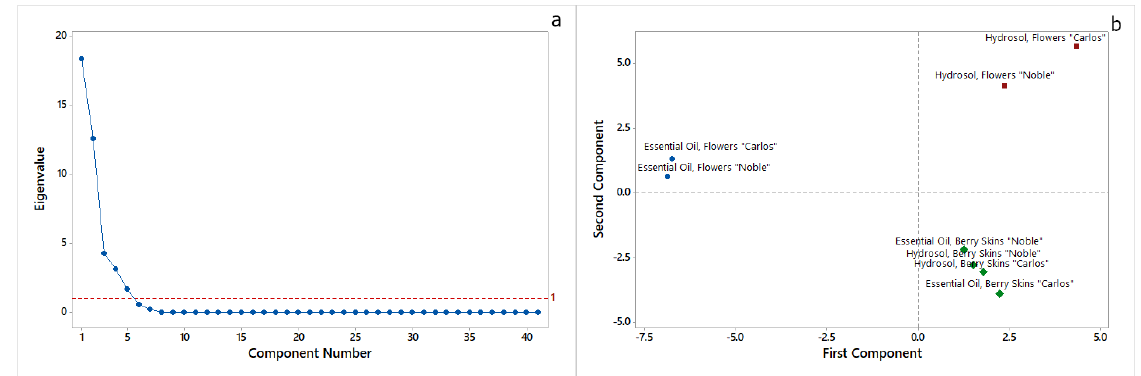
Figure 2. Scree plot ( a ) and score plot of the first two principal components ( b ), identified by principal components analysis (PCA) of volatile compounds in essential oils and hydrosols from two M. rotundifolia (Michx.) Small. cultivars.